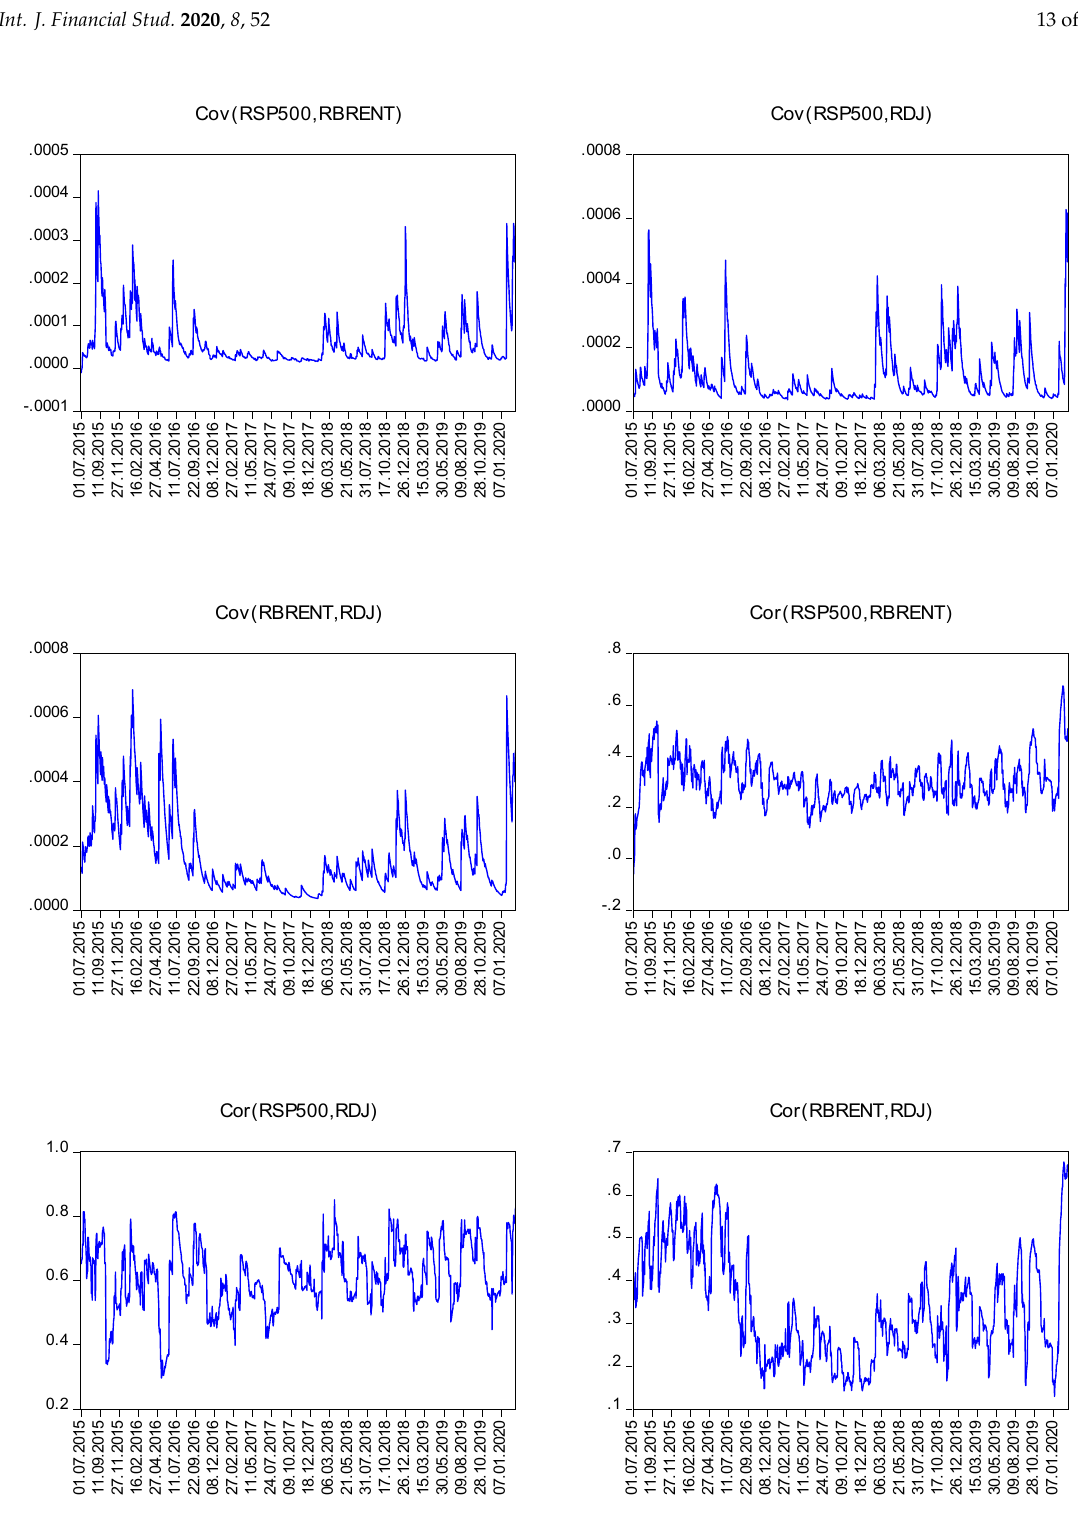
Figure 4. Covariance and correlations for Model 2.